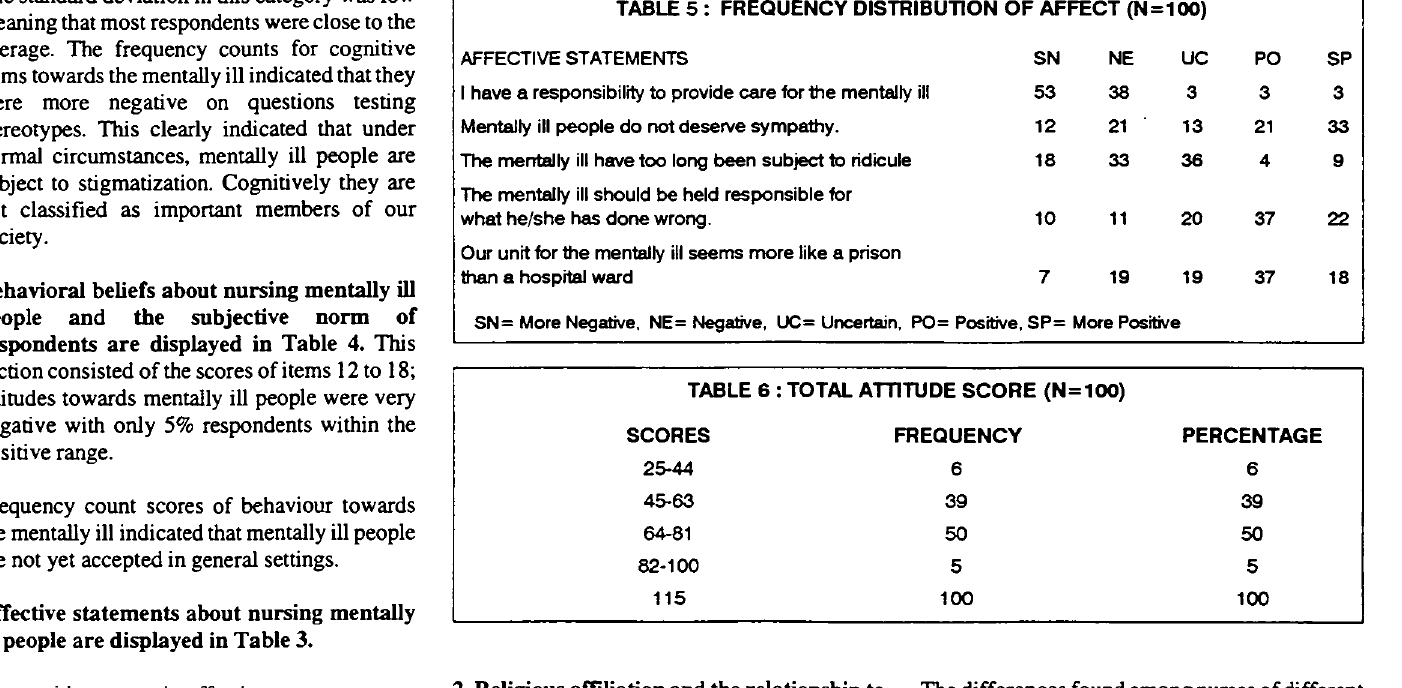
TABLE 5 : FREQUENCY DISTRIBUTION OF AFFECT (N==100)